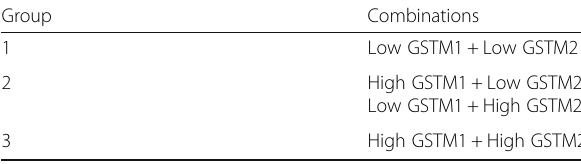
Table 2 The grouping information of joint-effects analysis